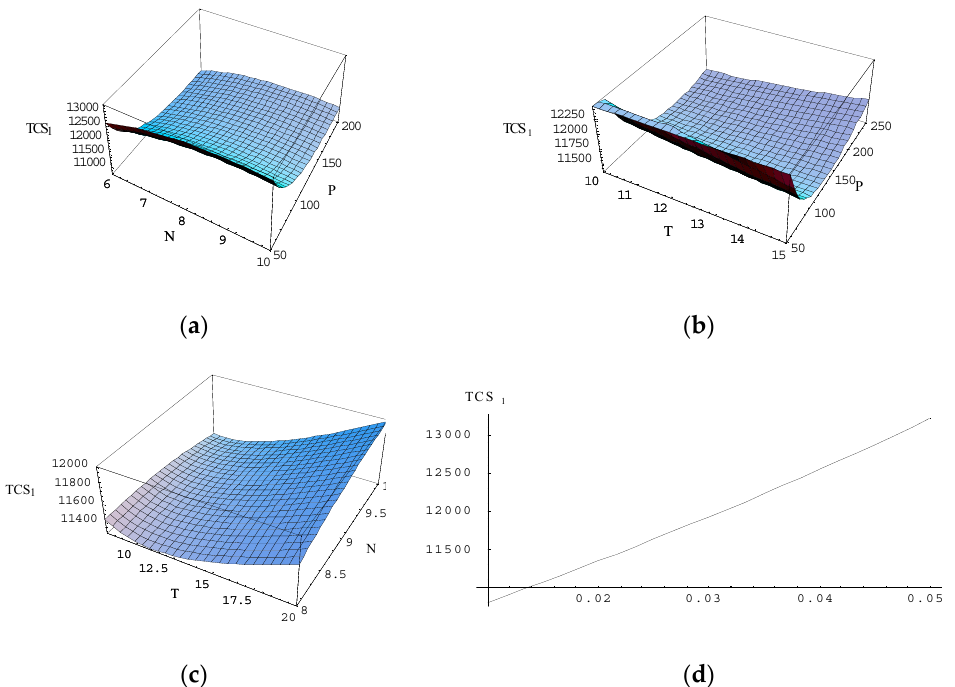
Figure 4. ( a ) Nature of total cost with respect to producer’s cycle length and production rate. ( b ) Nature of total cost with respect to credit period and production rate. ( c ) Nature of total cost with respect to producer’s cycle length and credit period. ( d ) Integrated cost for the products versus deterioration rate. Table 2. Sensitivity analysis of key parameters of the